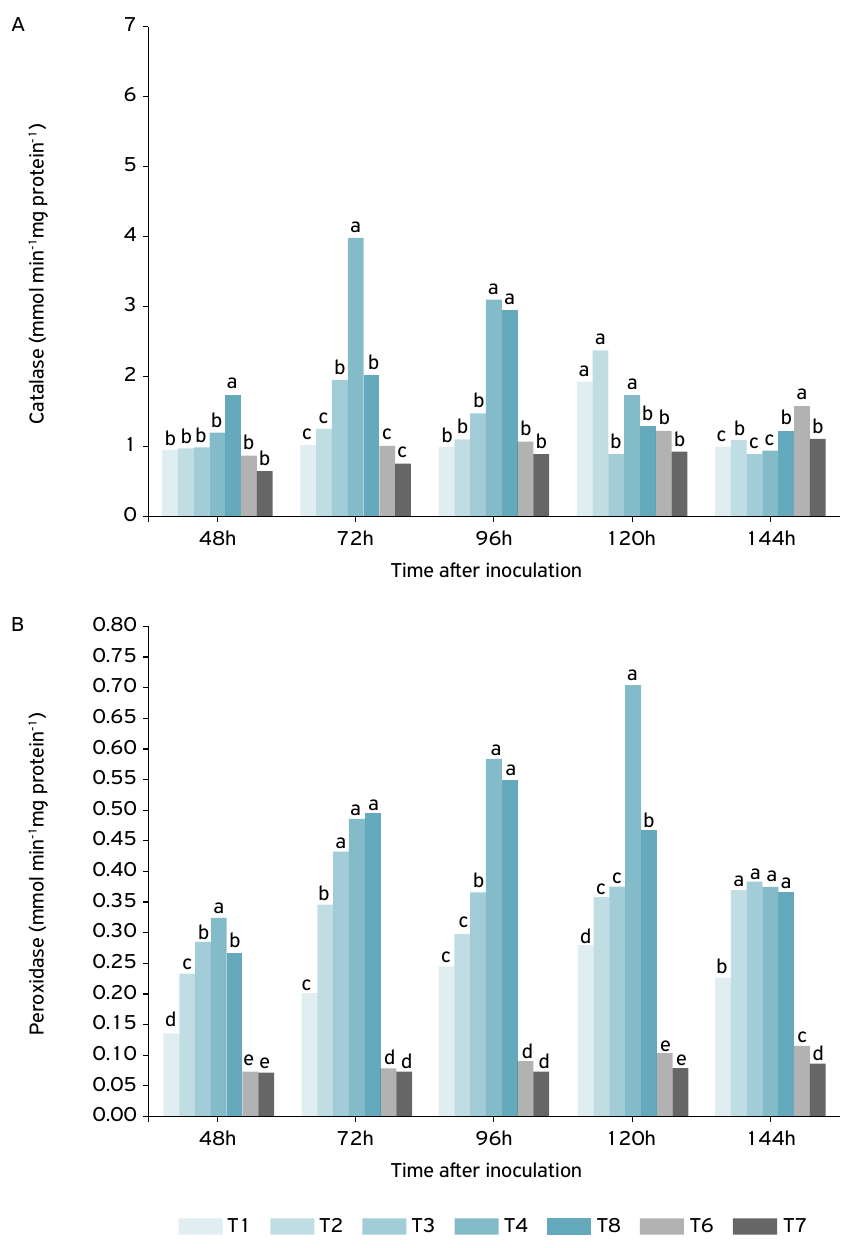
Averages followed by distinct letters between treatments differ by the Scott-Knott test at the 5% probability level; T1: suspension of Aspergillus japonicas ; T2: suspension of Trichoderma tomentosum ; T3: salicylic acid; T4: acibenzolar-s-methyl; T5: fungicide (Azoxystrobin with Tebuconazole); T6: application of sterile distilled water with inoculum of Bipolaris sorokiniana ; T7: without any Figure 2. Activity of the enzymes (A) catalase and (B) peroxidase, after inoculation of the Bipolaris sorokiniana pathogen.